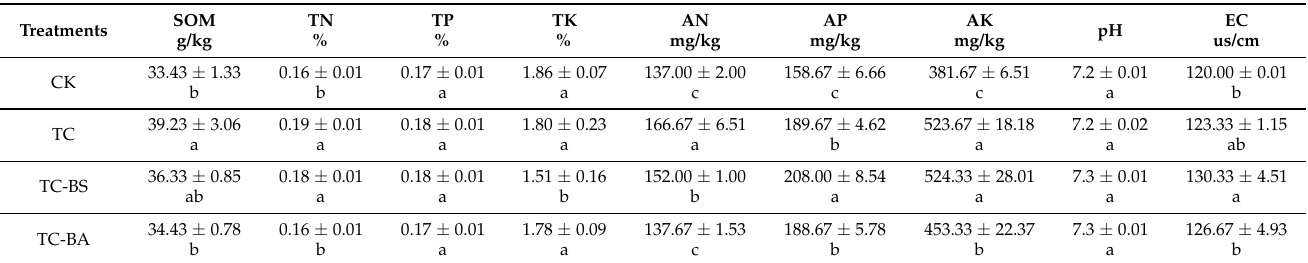
Table 1. Effect of applying tomato plant residue compost and PGPR on the nutrient content of ginger field